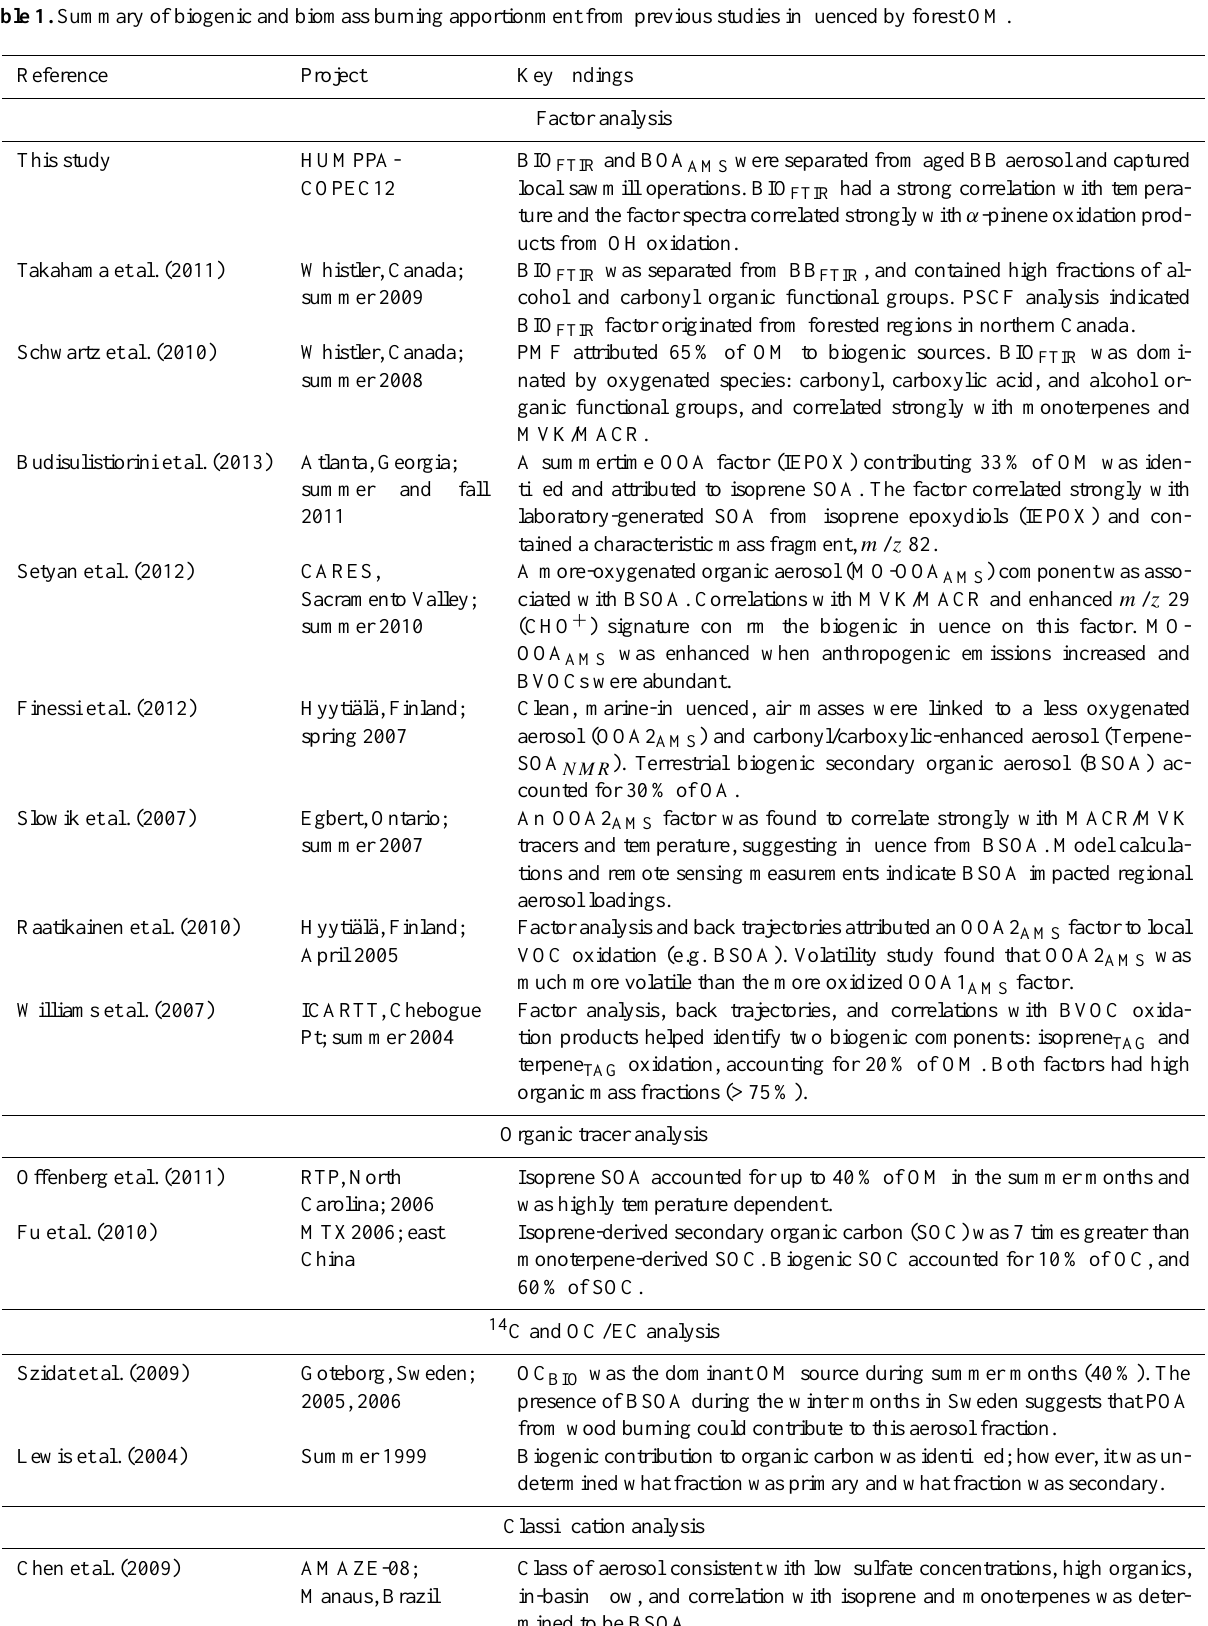
Table 1. Summary of biogenic and biomass burning apportionment from previous studies influenced by forest